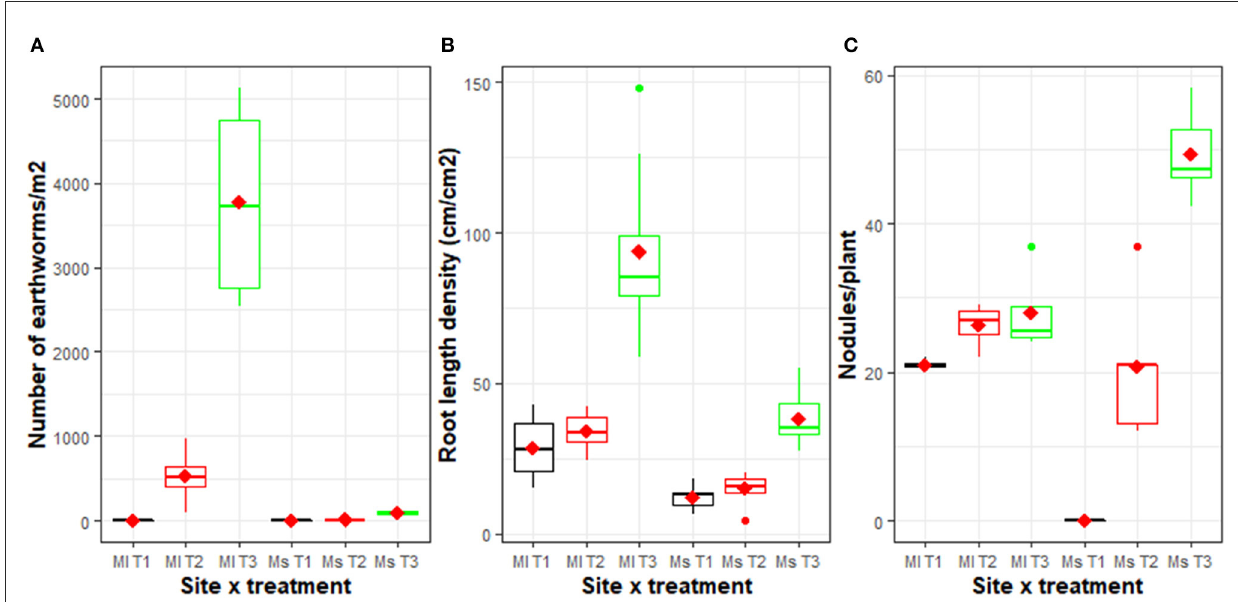
FIGURE5 Number of earthworms/m 2 (A) , aggregated root length density (cm/cm 2 ) (B) , and the number of root nodules per bean plant (C) in three management packages across two sites [Mulungu (Ml) and Mushinga (Ms)] measured after 4 years of experimentation. Root length was measured in the 0–50cm soil layer while earthworm populations were determined in the 0–30cm soil layer. The management practices included T3: an innovative agroecological package in which grasses, shrubs and mucuna cover crop had been integrated; T2: burning of weeds and crop residues with NPK and manure application; and T1: burning of weeds and crop residues without NPK and manure application. The horizontal line within each box is the median, while the diamond shaped symbol within the box is the mean. The lower and upper boundaries of the boxes are respectively, the 25th and 75th percentile; the bars/whiskers below and above the box are the 10th and 90th percentile and points beyond 10th and 90th percentiles are outliers.